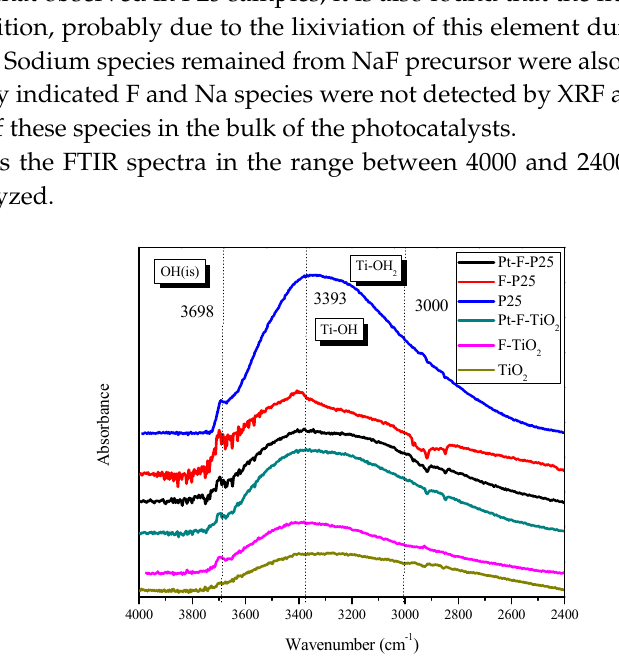
Figure 4. XPS spectra of the regions O 1s, Na 1s, F 1s and Pt4f in the photocatalysts analyzed.